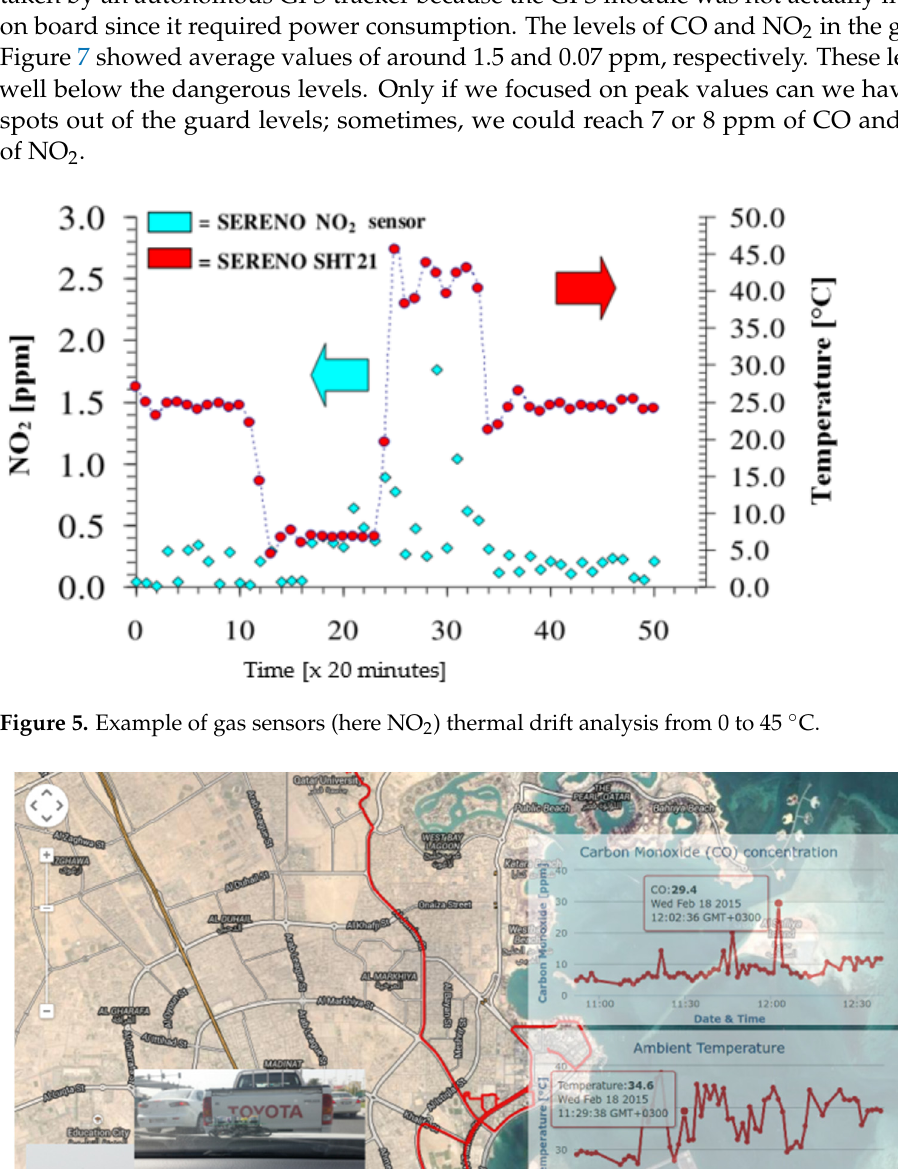
Figure 6. Example of measurement campaign in Doha (Qatar) traffic jam.